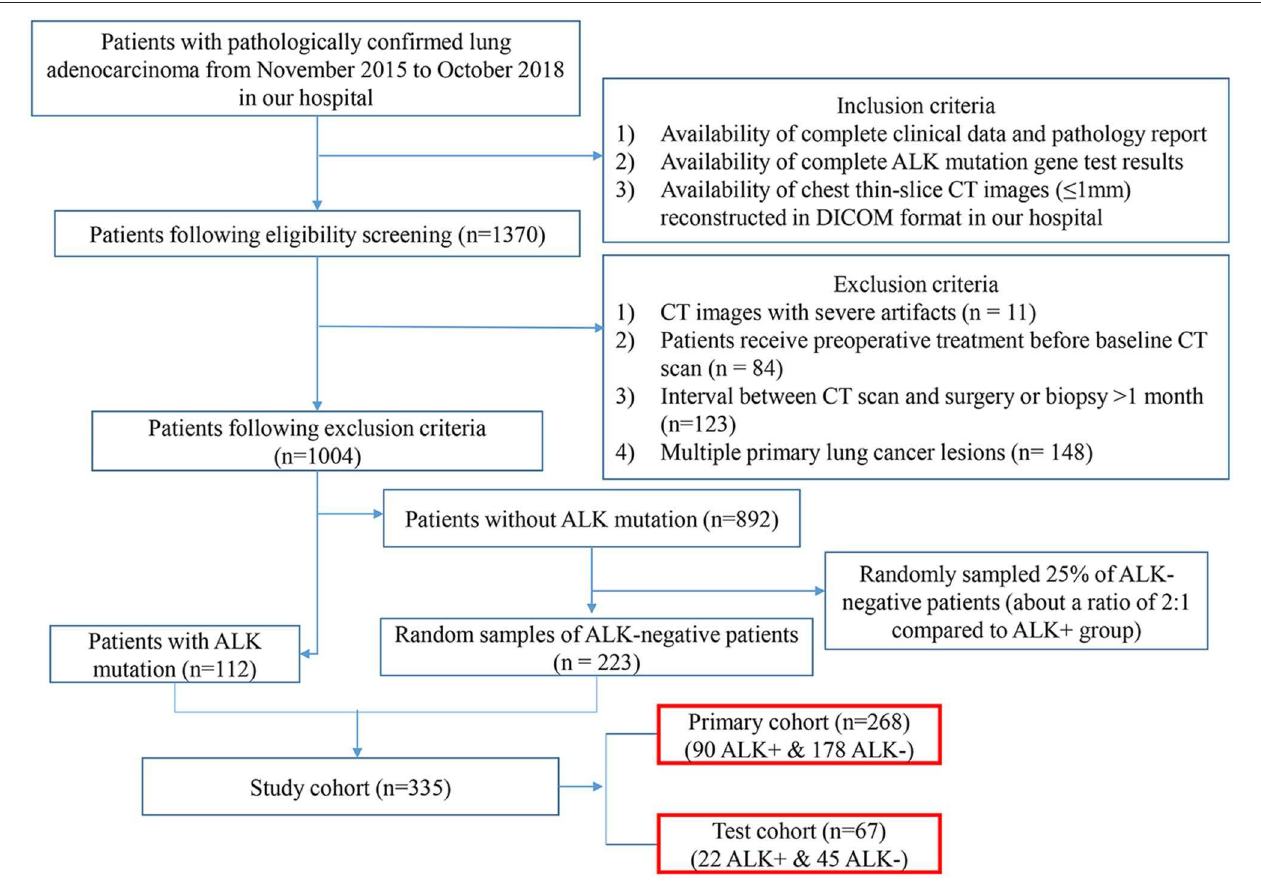
FIGURE 1 | Eligibility and exclusion criteria of the study. The flowchart depicts the process of patient enrolment, including eligibility, and exclusion criteria of the study. The numbers in parentheses are the numbers of patients. ALK, anaplastic lymphoma kinase; DICOM, Digital Imaging and Communications in Medicine.